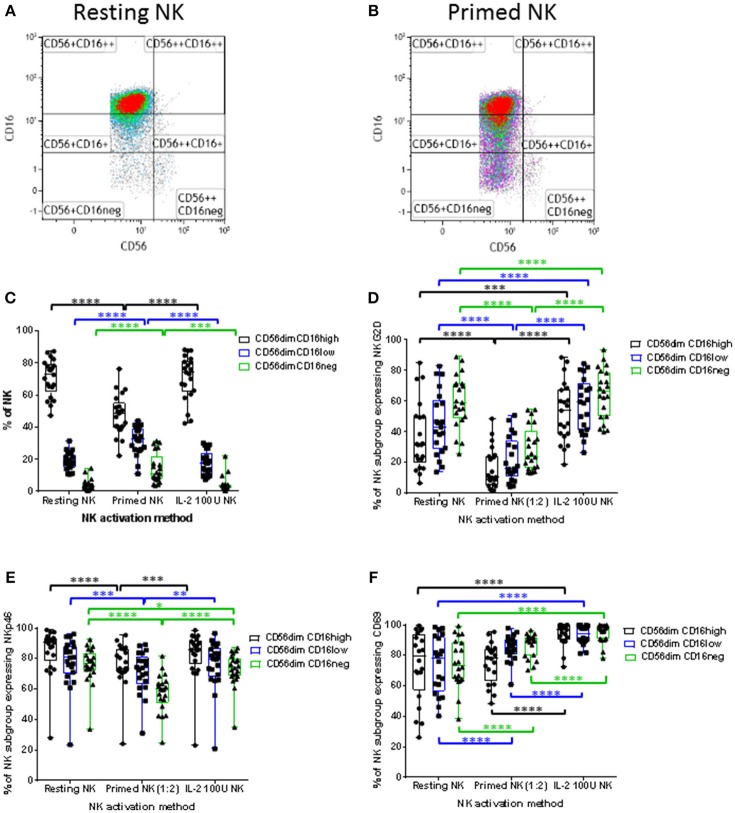
Influence of priming and IL-2 activation on CD16 expression by CD56dim NK cells and the expression of NKG2D, NKp46, and CD69 expression by CD56dim NK cell subpopulations expressing different levels of CD16. For each patient, isolated NK cells were either primed with mitomycin C treated CTV-1 cells at a 1:2 ratio or activated with 100 IU IL-2, after which their expression of CD16, NKG2D, NKp46, and CD69 was measured by flow cytometry and compared to that of resting NK cells. (A,B) Strategies for the gating of live, single cell, NK subpopulations based on CD56, and CD16 expression for both resting and primed NK cells, respectively. (C) Box and whisker plot comparing the proportion of CD56dimCD16high, CD56dimCD16low, CD56dimCD16neg populations before and after priming, and IL-2 activation. For each CD56dim subpopulation before and after NK cell activation, box and whisker plots analyzing the proportion of NK cells expressing (D) NKG2D, (E) NKp46, and (F) CD69. Statistical analysis was performed using two way ANOVA repeated measure tests combined with Tukey's multiple comparisons test and 95% confidence intervals. * < 0.05, ** < 0.01, *** < 0.001, **** < 0.0001.